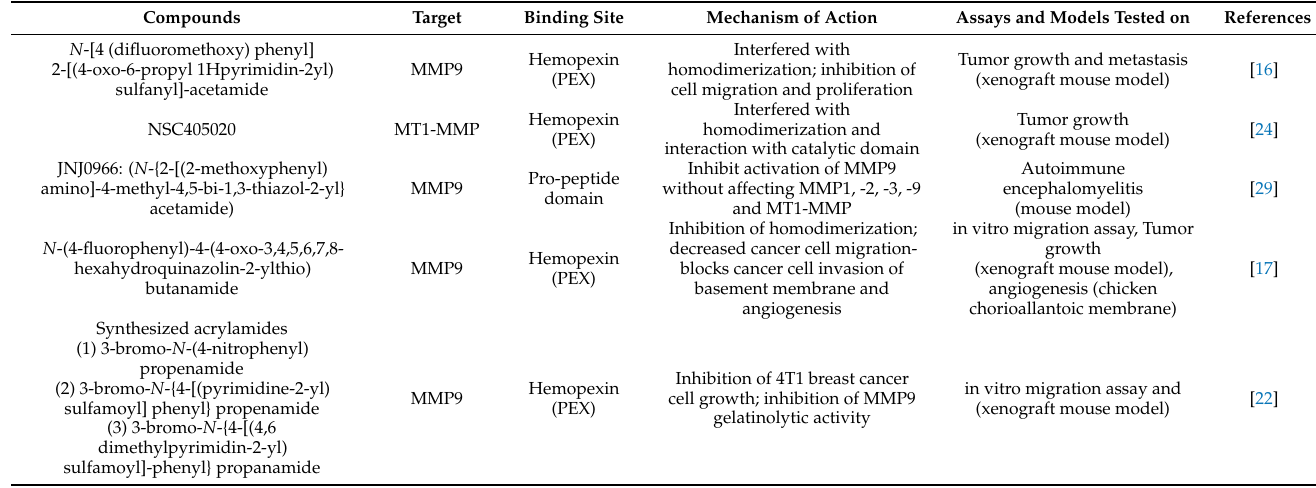
Table 2. Small molecule exosite MMP inhibitors.